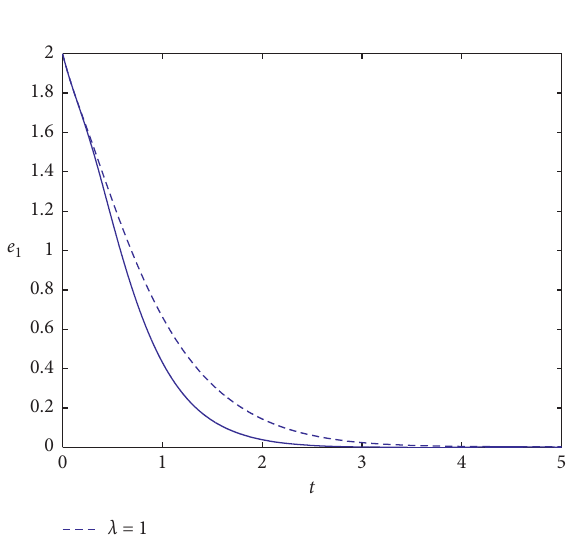
Figure 2: The chaos attractor of system (48) with y